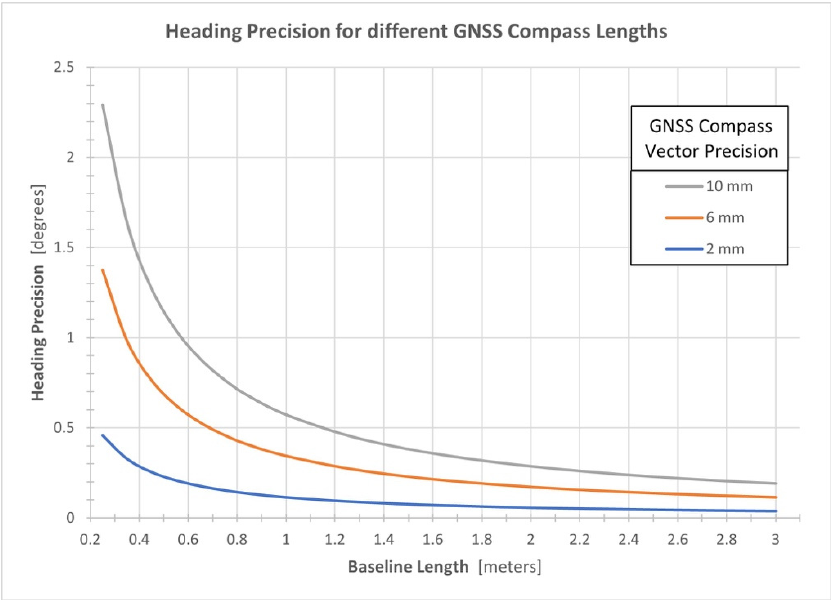
Figure 3. Theoretical GNSS compass heading precisions for different GNSS compass baseline lengths.